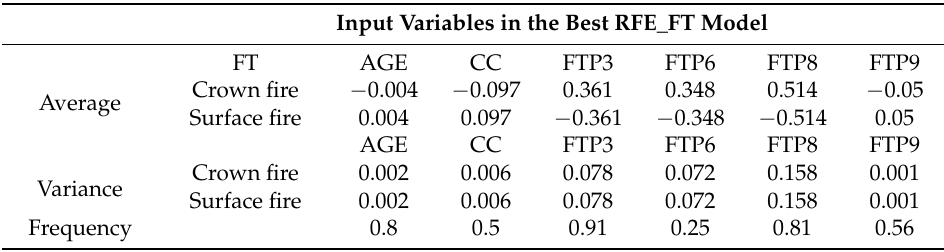
Table 11. Sensitivity analysis of the best model for the classification of Fire Type within reforested stands of Eucalyptus